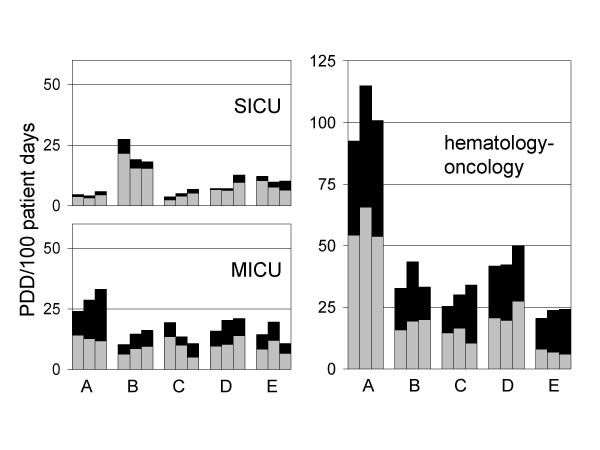
Use of fluconazole (grey bars) versus other systemic antifungal drugs (black bars) in the SICU, MICU, and in the hematology-oncology services of five university hospitals (A through E) during the years 2001–2002–2003.